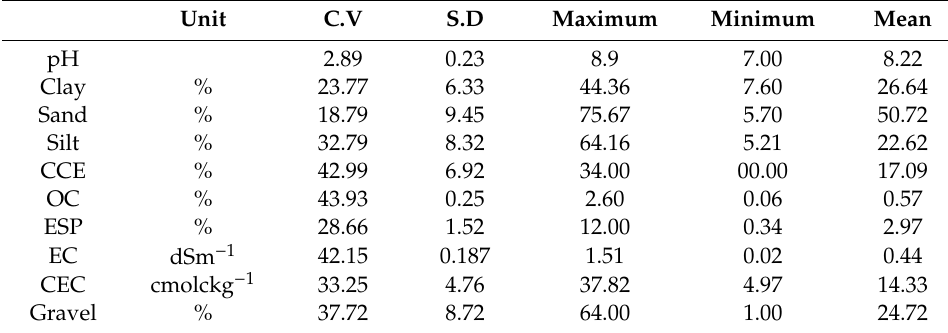
Table 2. Descriptive statistics for soil